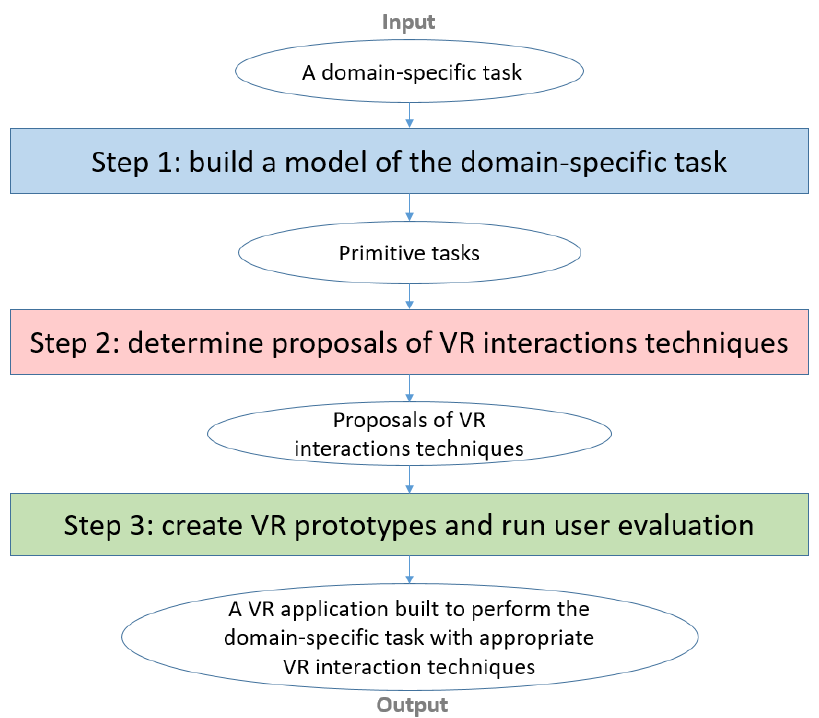
Figure 1. Overview of our task-centred methodology to design and evaluate VR user